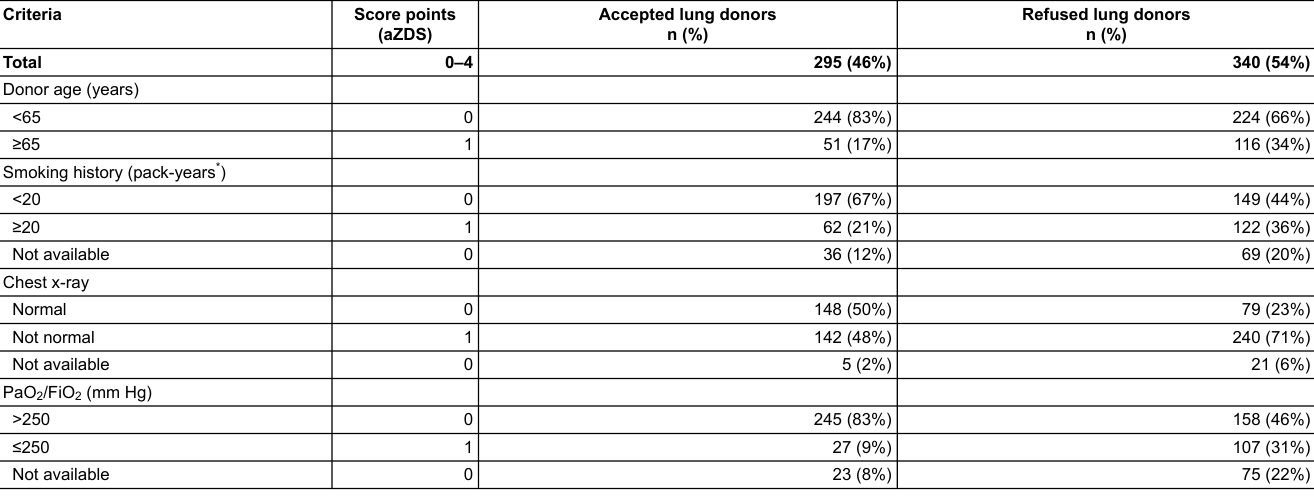
Table 3: Composition of the adapted Zurich donor score (aZDS) for accepted vs refused lung donors.